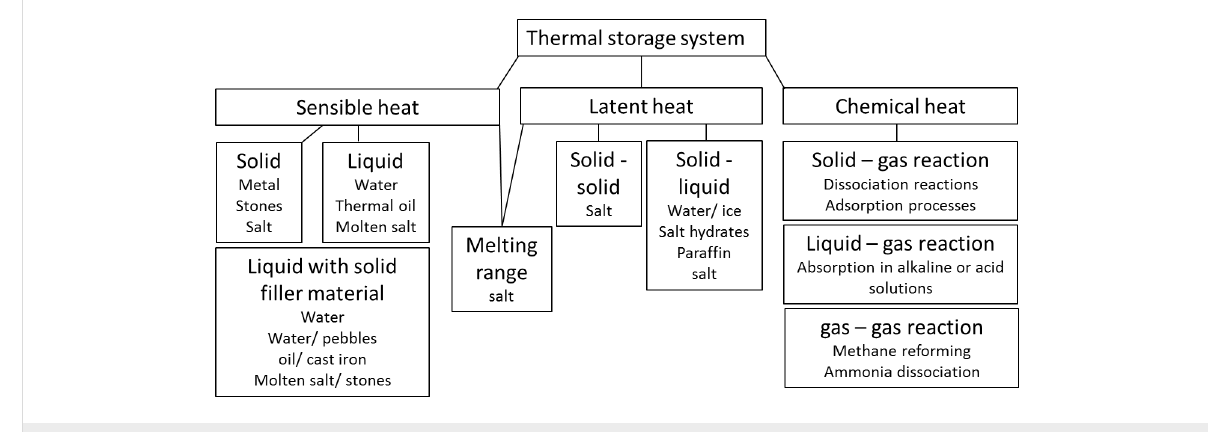
Figure 1: Classification of heat storage media.